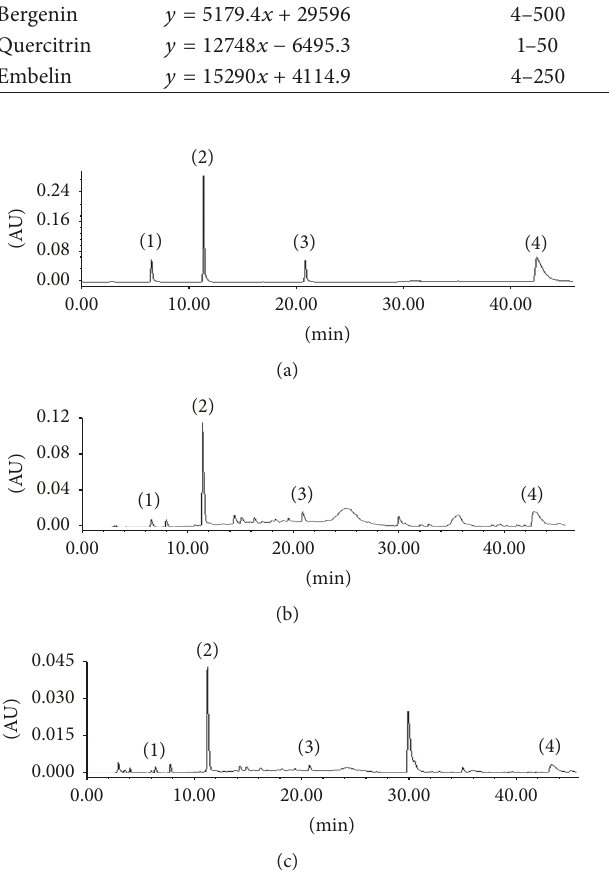
Figure 6: The typical HPLC chromatograms of (a) the mixed stan- dardsolutions:(1)gallicacid,50 𝜇 gmL −1 ;(2)bergenin,500 𝜇 gmL −1 ; (3) quercitrin, 50 𝜇 gmL −1 ; (4) embelin, 250 𝜇 g mL −1 ; (b) sample extractedbyultrasonicassistedmicellarextractionandthenprecon- centrated by cloud point extraction: (1) gallic acid, 5.58 𝜇 gmL −1 ; (2) bergenin, 216.65 𝜇 gmL −1 ; (3) quercitrin, 12.72 𝜇 g mL −1 ; (4) embelin, 48.45 𝜇 g mL −1 ; (c) sample extracted by ultrasonic assisted micellar extraction. (1) gallic acid, 1.09 𝜇 gmL −1 ; (2) bergenin, 39.93 𝜇 gmL −1 ; (3) quercitrin, 2.59 𝜇 gmL −1 ; (4) embelin, 10.46 𝜇 gmL −1